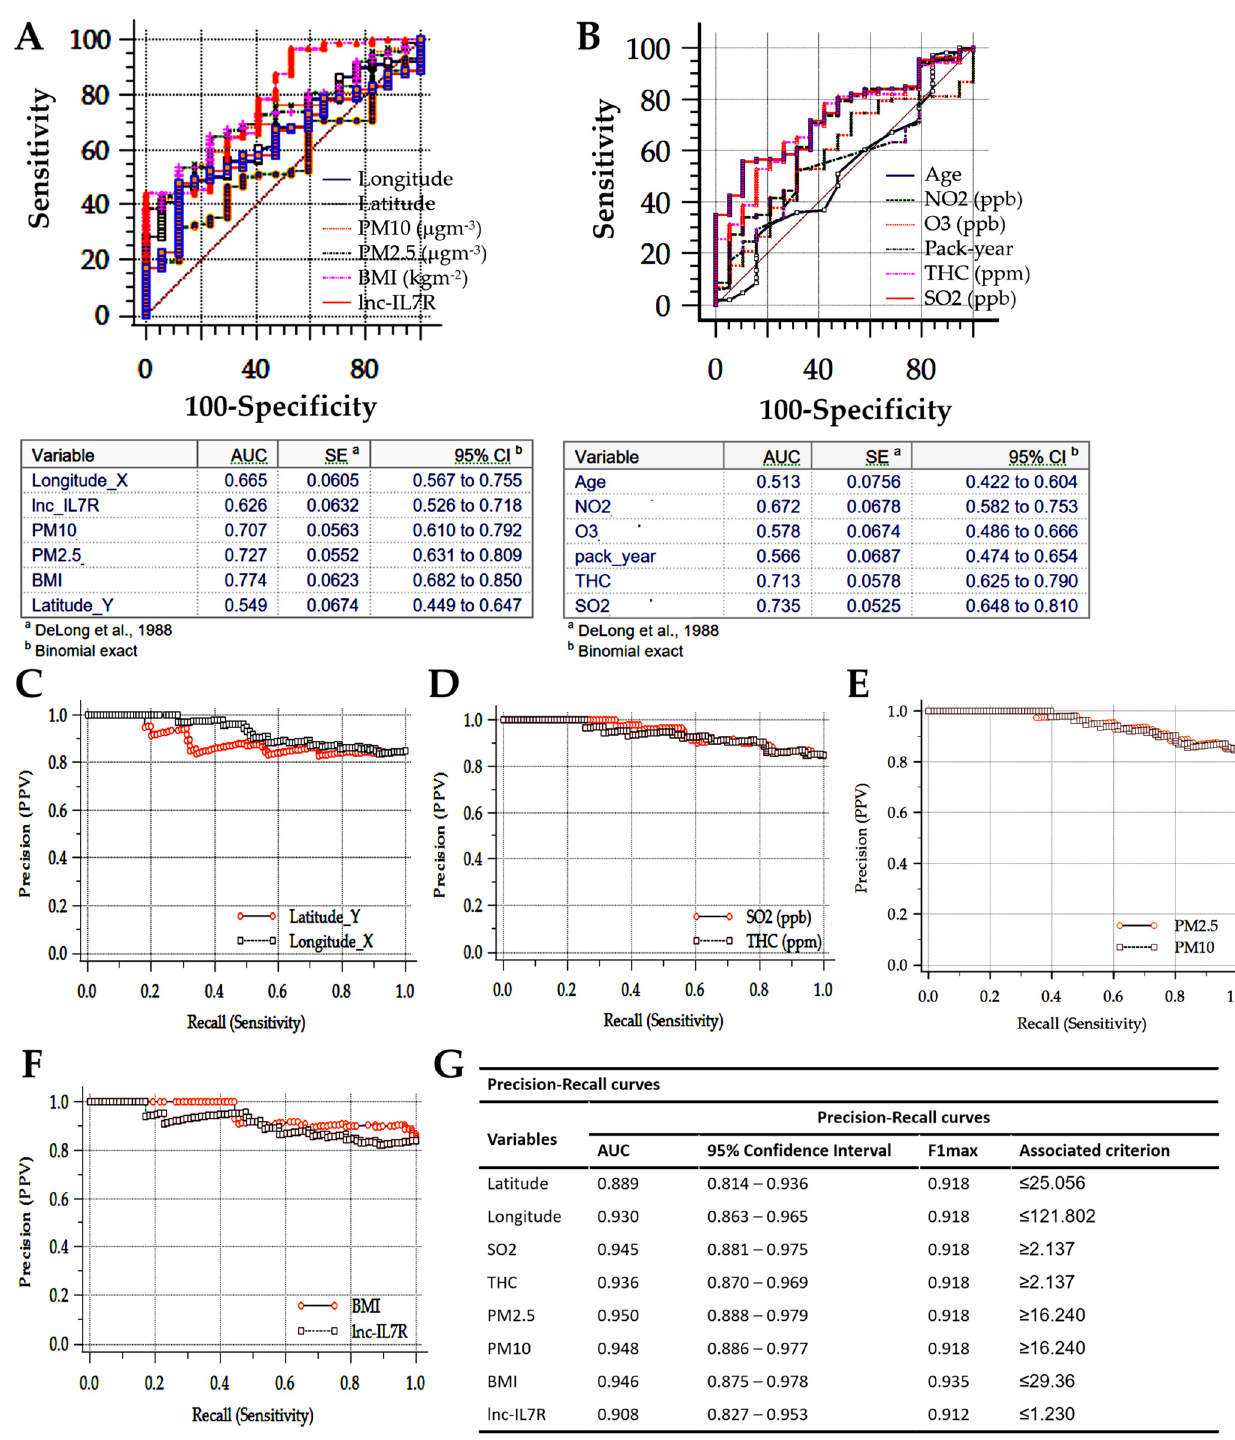
Figure 4. Combined BMI, lnc-IL7R , PM 2.5 , PM 10 , and SO 2 levels are optimal classifiers for accurate patient stratification and COPD-E management triage in Taiwan. Visual representation (upper panel) and statistics chart (lower panel) of the area under the receiver operating characteristics curves for ( A ) longitude, latitude, PM 10 , PM 2.5 , BMI, lnc-IL7R , ( B ) age, NO 2 , O 3 , pack-year, THC, and SO 2 . Precision–recall curves showing the tradeoff between precision and recall for ( C ) longitude, latitude, ( D ) THC, SO 2 , ( E ) PM 2.5 , PM 10 , ( F ) BMI, and lnc-IL7R . ( G ) Statistics chart of the precision–recall curves for ( C – F